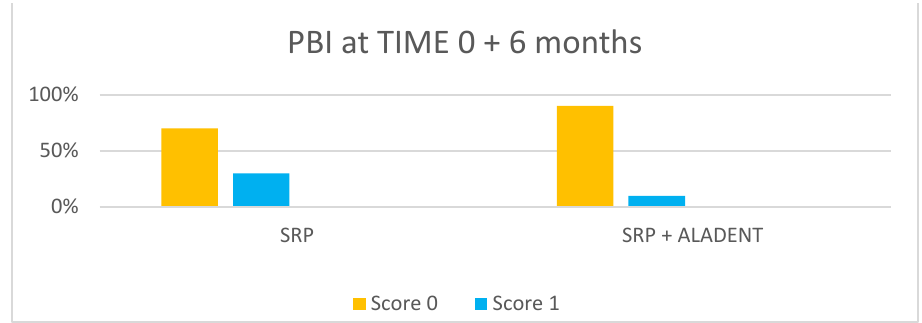
Figure 5. CAL and PD mean values (mm) of the selected sites after treatment with SRP alone and SRP plus ALADENT.